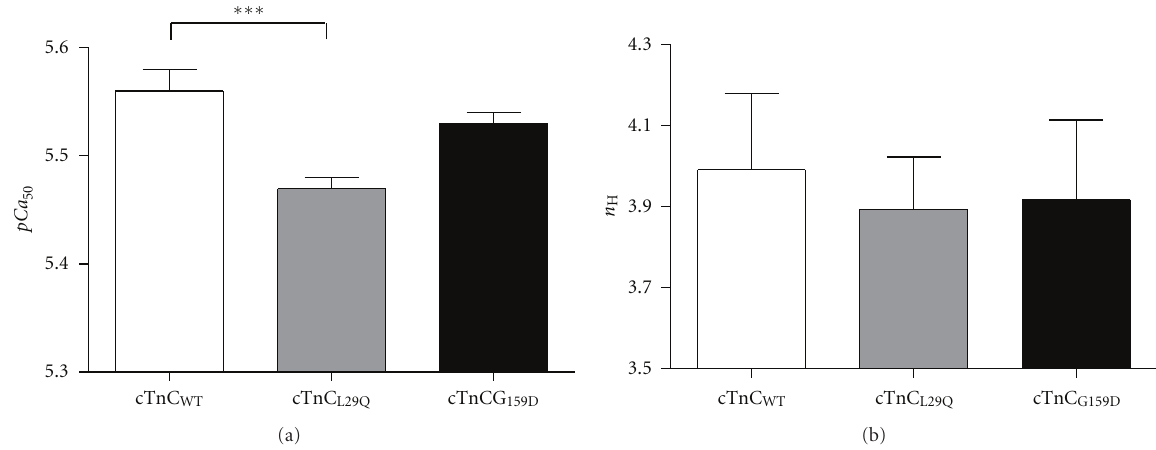
Figure 5: Comparison of myofilament Ca 2+ sensitivity ( pCa fibers reconstituted with cTnC WT , ccTnC L29Q , or cTnC G159D . (a) E ff ects of RcTnC mutants on pCa The Hill equation was fitted to the normalized pCa-tension relationships to estimate pCa and n H estimates in cTnC L29Q and cTnC G159D fibers with the data from cTnC WT fibers as controls. Values are expressed as mean ± SEM. pCa 50 Number of fibers tested in each group is as follows: cTnC WT , n = 15; cTnC L29Q , n = 10; cTnC G159D , n = 14. Minimal statistical significance was set at α = 0 . 05. ∗∗∗ P < 0 . 001.